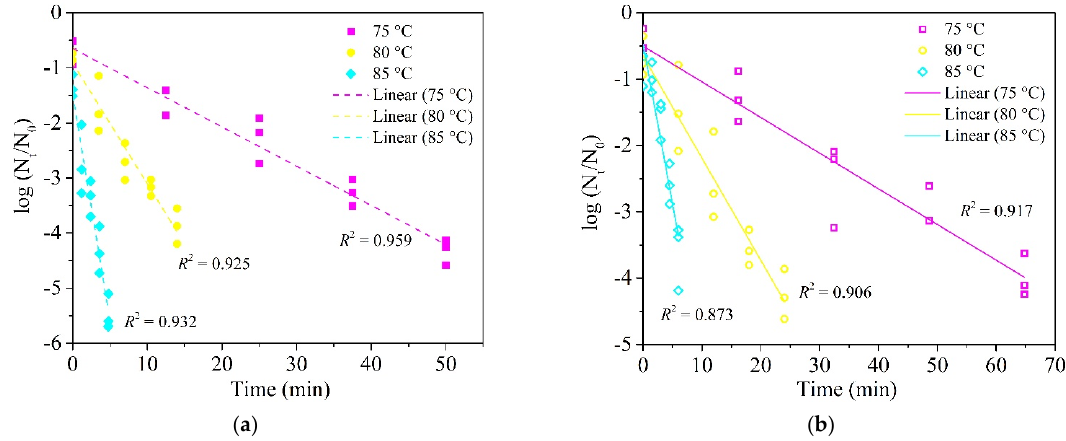
Figure 2. Inactivation kinetic curves of E. faecium in wheat granules (a w = 0.66) ( a ) and flour (a w = 0.65) ( b ) at 75, 80 and 85 °C under a fixed heating rate of 5 °C/min in the HBS.